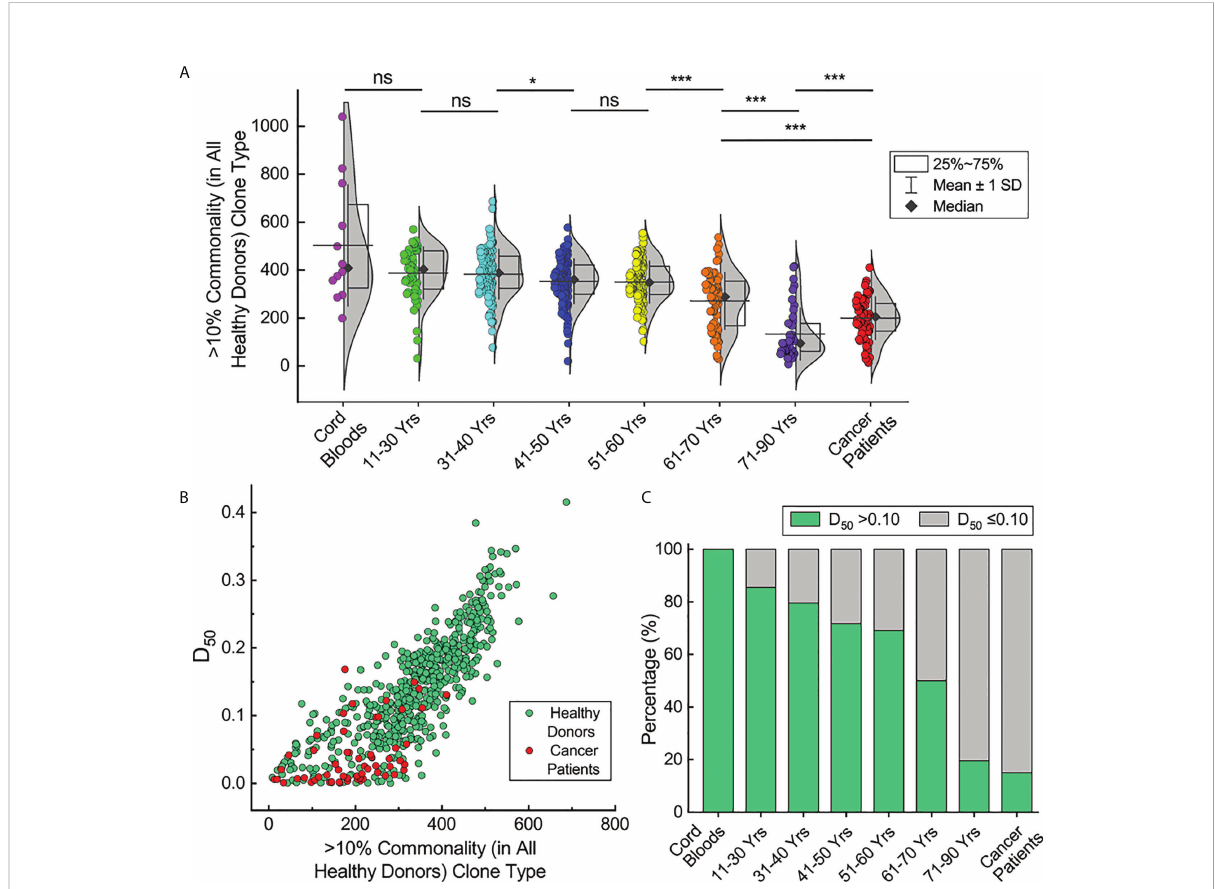
FIGURE 6 Correlation of TCR b clone commonality with repertoire diversity. (A) HCTC types in individual repertoires of the cord blood samples, healthy donors in different age groups and cancer patients. (B) Correlation of HCTC types with repertoire diversities for repertoires of healthy donors and cancer patients. (C) Percentage of repertoires with >0.10 diversity index values in each subgroup. The asterisks indicate p -values of the Mann-Whitney U test (* p < 0.05; *** p < 0.001). ns, not signi fi